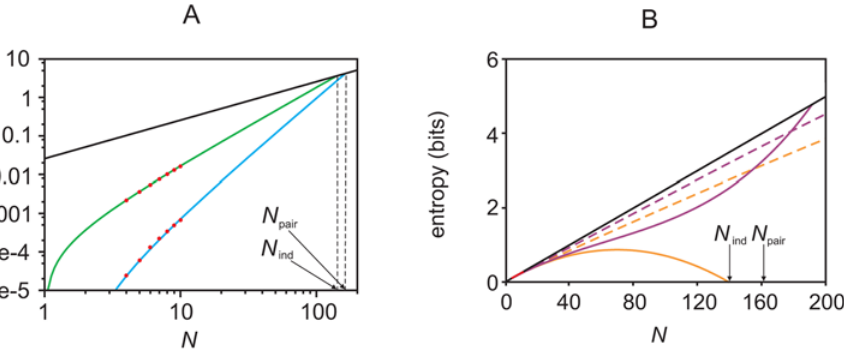
Figure 4. Cartoon showing extrapolations of the zeroth order KL divergences and entropies (see Eqs. (9) and (11)). These extrapolations illustrate why the two natural quantities derived from them, N ind and N pair , occur beyond the point at which the extrapolation is p true k p ind ð Þ ; cyan: D 0 p true k p pair (cid:1) (cid:2) . The red points are the data. The points meaningful. (A) Extrapolations on a log-log scale. Black: S ind ; green: D 0 KL KL N ind and N pair label the intersections of the two extrapolations with the independent entropy, S ind . (B) Extrapolation of the entropies rather than the KL divergences, plotted on a linear-linear scale. The data, again shown in red, is barely visible in the lower left hand corner. Black: S ind ; solid orange: S 0 ; solid maroon: ~ SS 0 . The dashed orange and maroon lines are the extrapolations of the true entropy and true pairwise ‘‘entropy’’, respectively. true pair